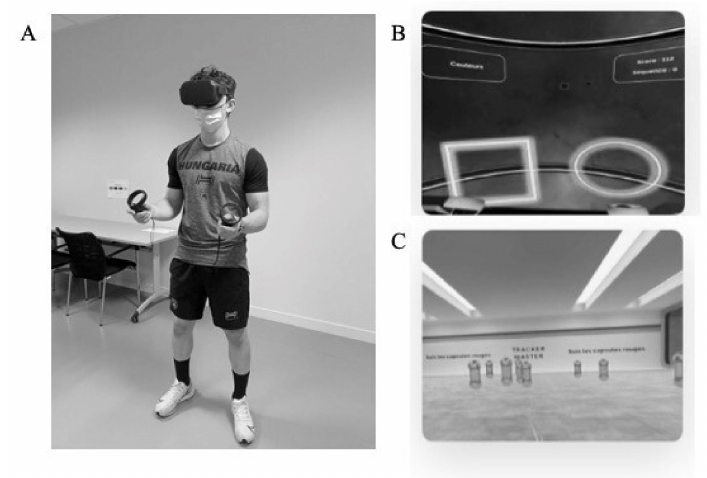
Figure 1. Player position during the virtual reality task ( A ) and illustration of the Beat Master ( B ) and Tracker Master games ( C